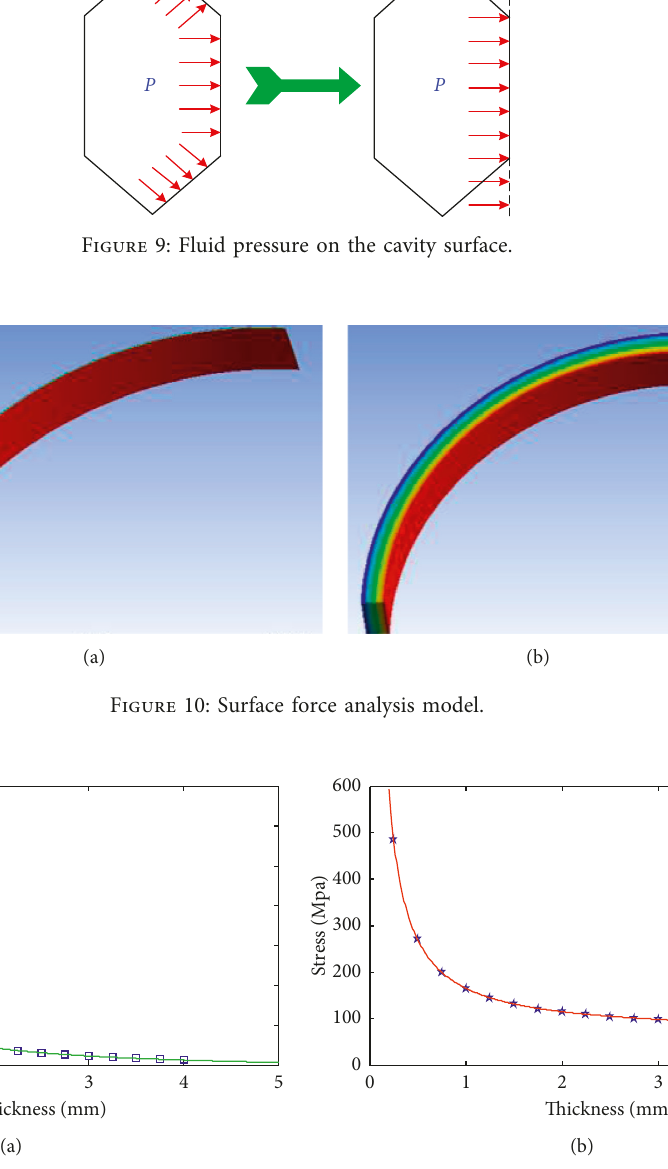
Figure 11: The relationship between thickness and stress and deformation.